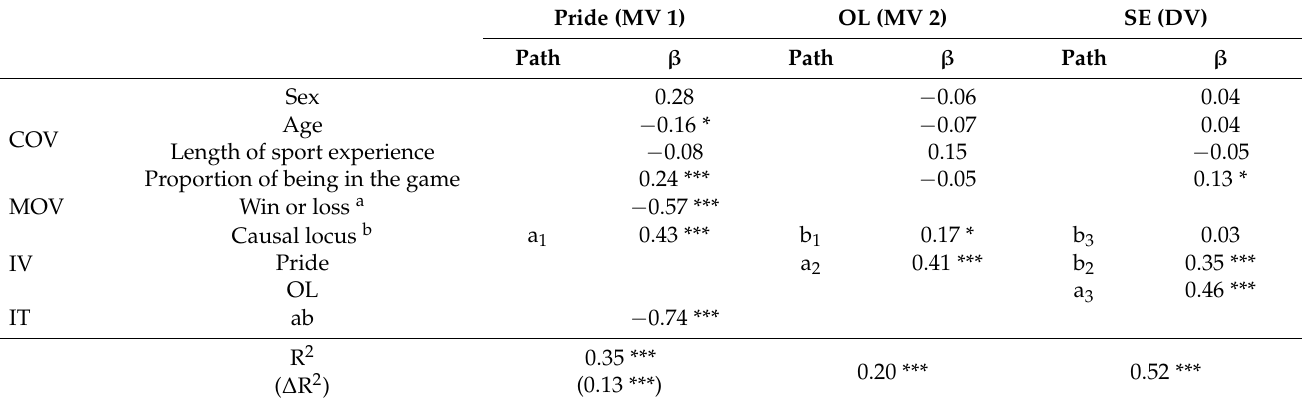
Table 5. Analysis 1: Double-Mediating Effects in Winning and Losing